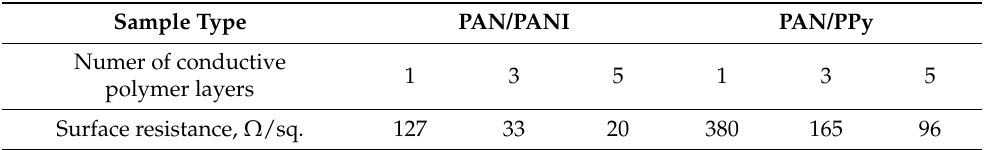
Table 2. Surface resistance of PAN/PANI and PAN/PPy samples as a function of the number of inkjet-printed polymer